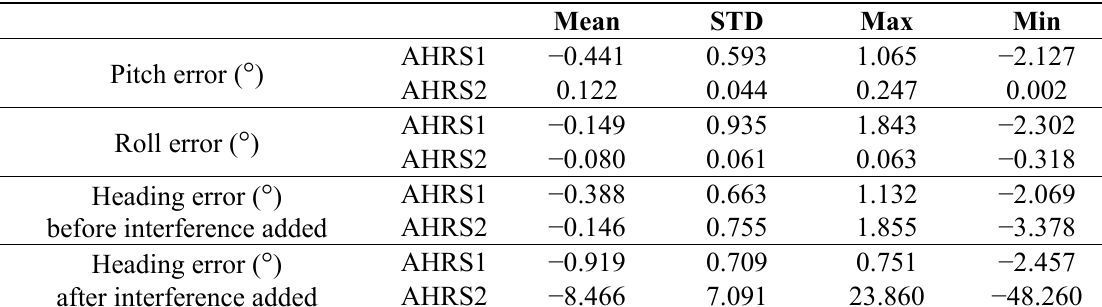
Table 5. Statistics of the third